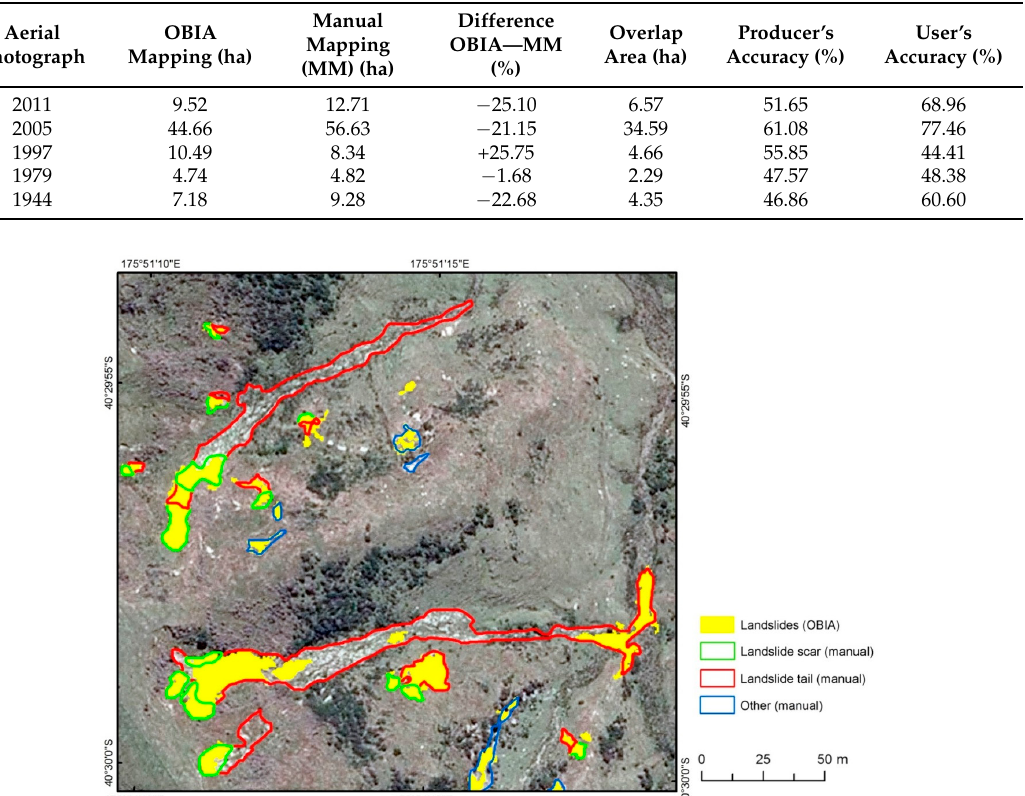
Table 2. OBIA and manual mapping results, difference between OBIA and manual mapping results, overlapping area, and producer’s and user’s accuracy for each image acquisition date.